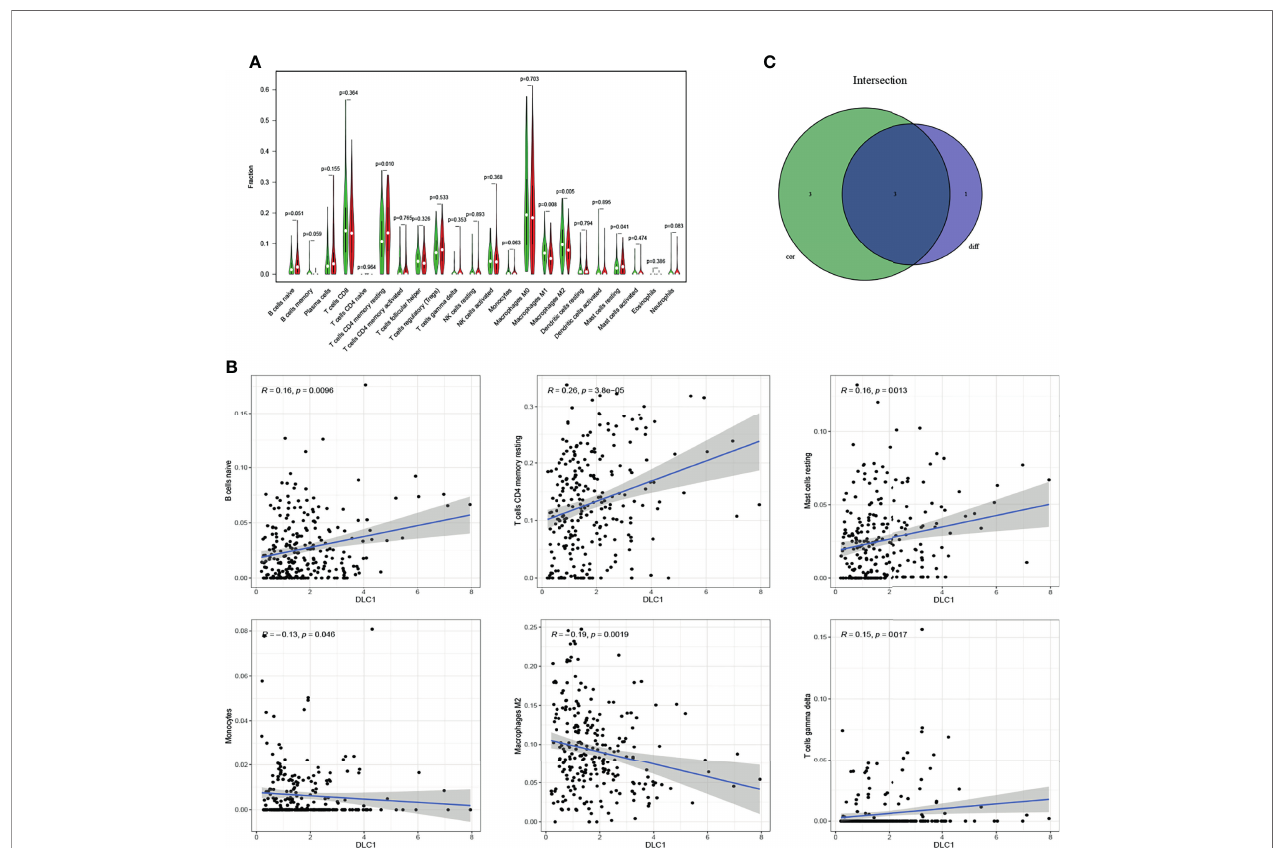
FIGURE 7 | Relationship between TIC proportion and DLC1 expression. (A) Differentiation of 21 kinds of immune cells in UCEC tumor samples with low- or high- DLC1 expression compared with the median of DLC1 expression level was shown by a violin plot. The signi fi cance test was displayed using Wilcoxon rank-sum. (B) Scatter plot showed the relationship between six kinds of TICs in proportion with the DLC1 expression ( P < 0.05). The blue line in each plot was fi tted into a linear model indicating the proportion of tropism of the immune cells along with DLC1 expression; the correlation test was displayed using the Pearson correlation coef fi cient. (C) Venn plot presented three kinds of TICs relative to DLC1 expression co-determined by difference and correlation tests indicated in violin and scatter plots,